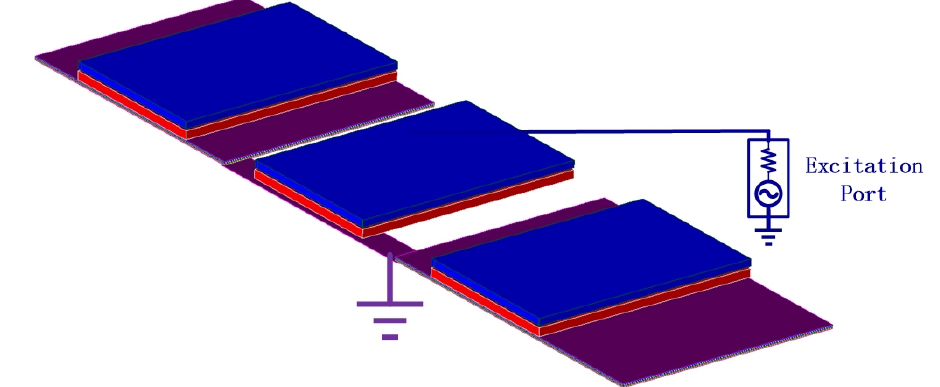
Figure 10. EM simulation setup for parasitic capacitor extraction of GSG